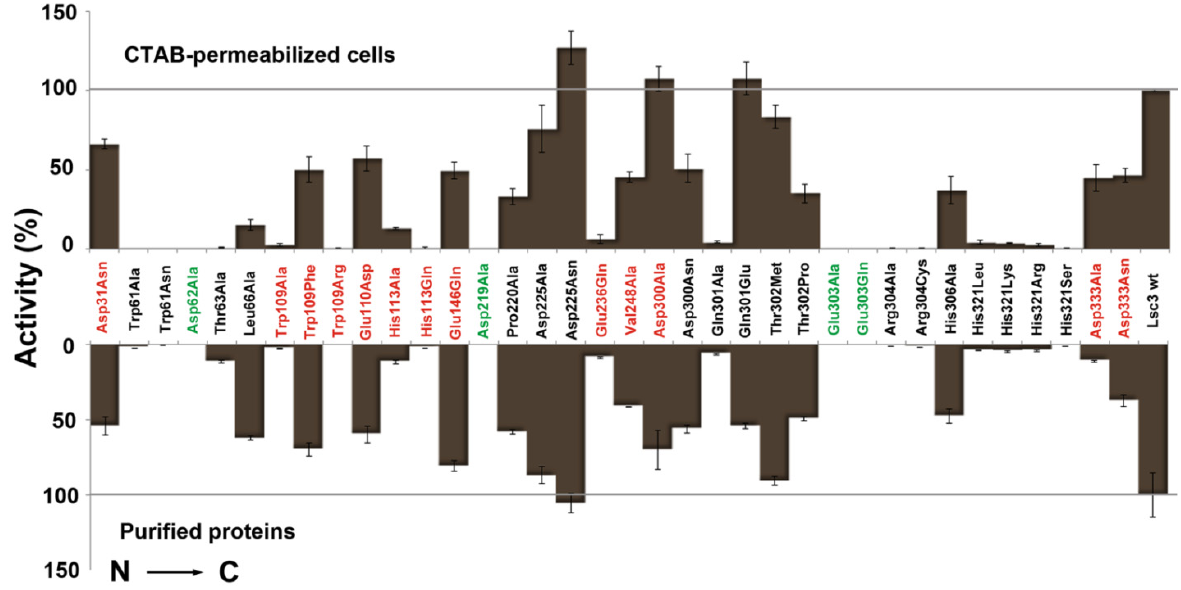
Figure 4. Quantitative evaluation of the sucrose-splitting (total) levansucrase activity on microplates. Either CTAB-permeabilized E. coli transformants expressing a certain Lsc3 variant (upper panel) or respective purified proteins (lower panel) were used as catalysts. Respective methods are described in Sections 3.3 and 3.4. Mutants of catalytic triad positions are designated in green and Lsc3 mutants studied for the first time in red. Mutant Glu303Gln falls into both categories. The activities of mutant enzymes are expressed as percentage of respective value of wild-type Lsc3 taken as 100% (grey lines). Total activity of purified wild-type Lsc3 protein was 461.6 ± 95.5 U/mg. In the assay on permeabilized cells, the absorption values at 500 nm indicating glucose concentration were normalized to cell suspension densities and the value obtained for wild-type Lsc3 was taken as 100%. At least three parallel measurements for each levansucrase variant were made and mean values with respective standard deviations are